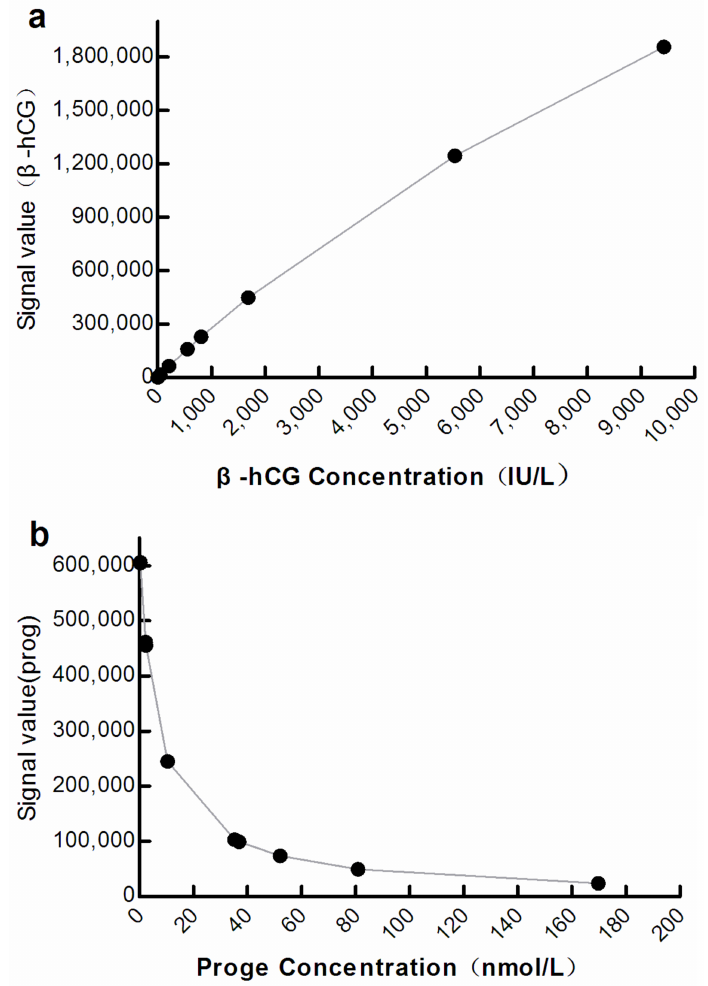
Figure 3. Curve showing correlation between the optical signal and analyte concentration at M3.